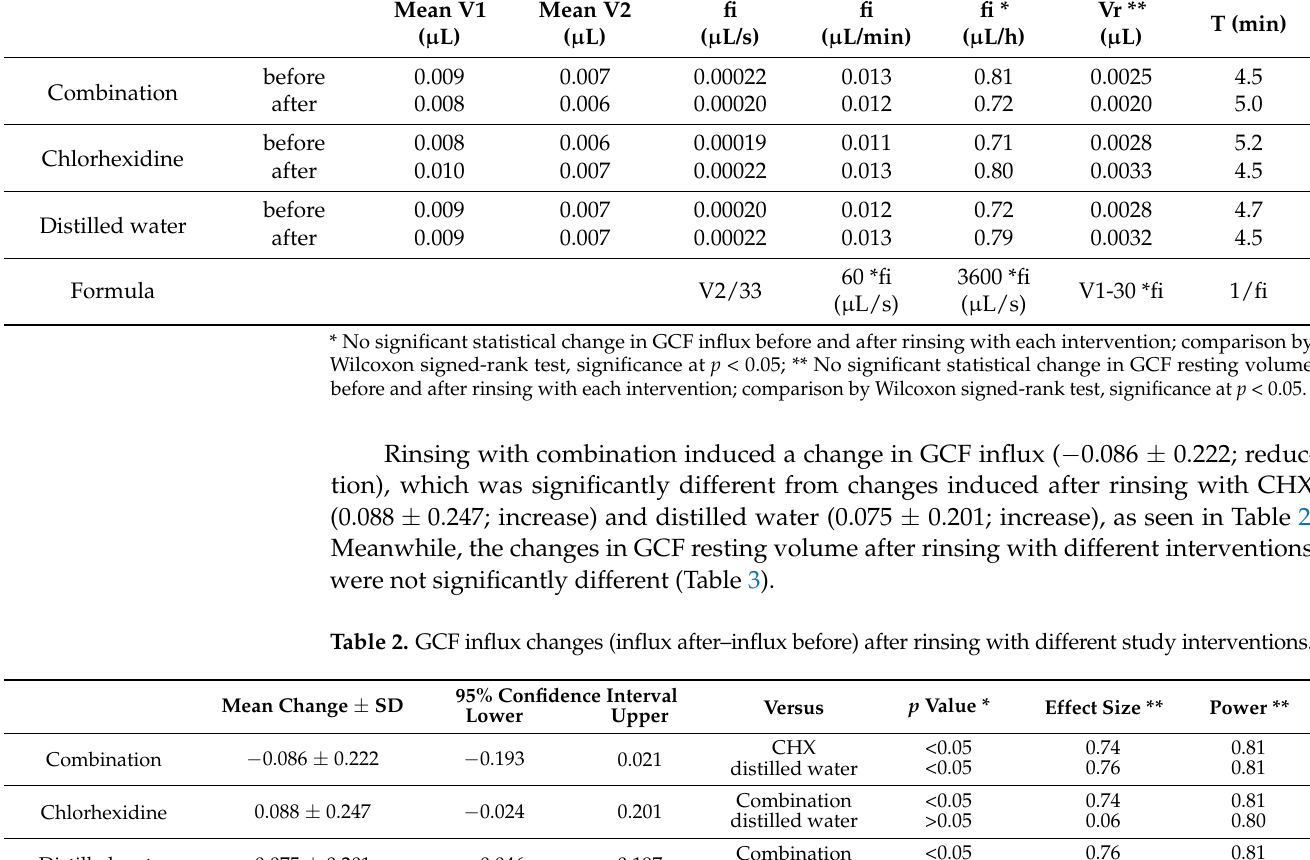
Table 1. Estimation of GCF influx (fi), resting volume (Vr) and the time needed to form 1 mL (T) before and after rinsing with interventions. Mean V1 Mean V2 ( µ L)